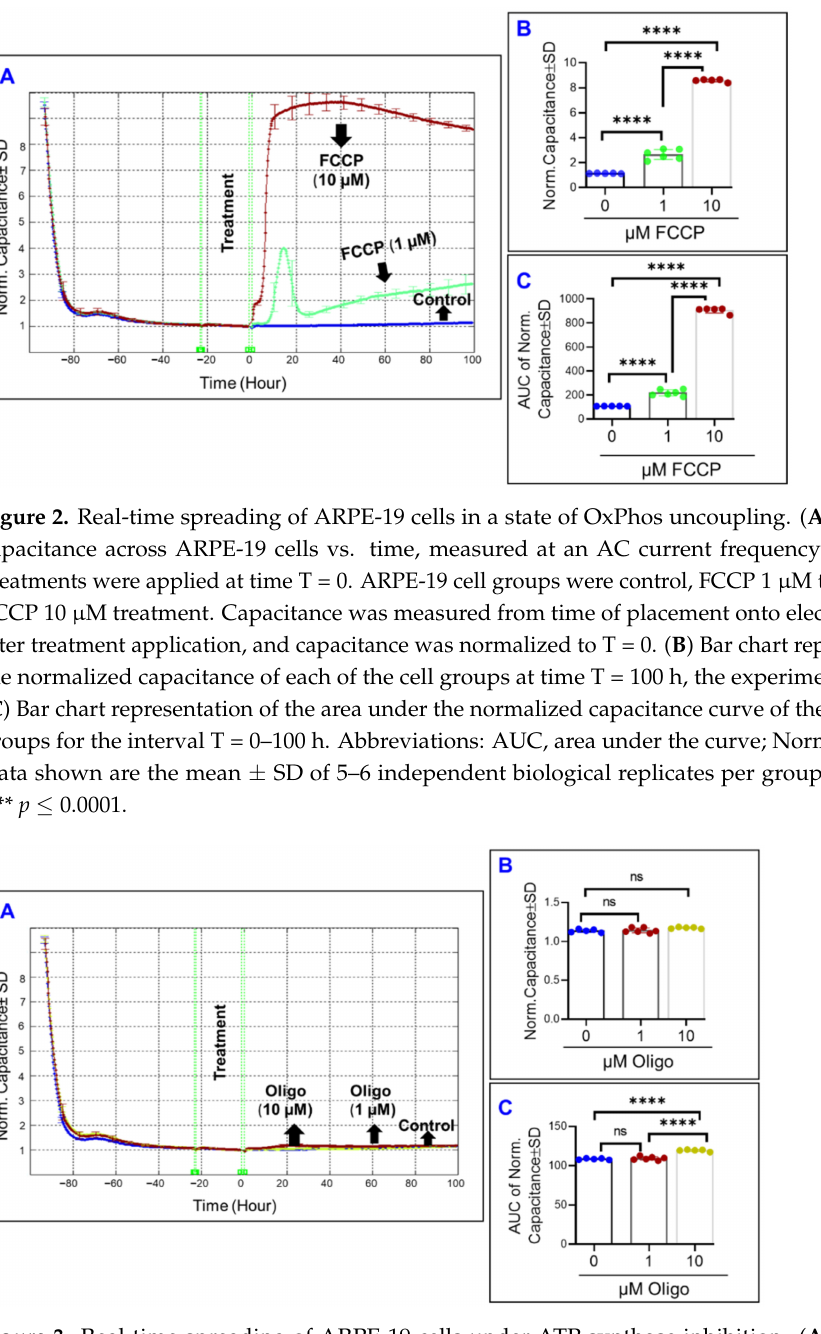
Figure 3. Real-time spreading of ARPE-19 cells under ATP synthase inhibition. ( A ) Normalized capacitance across ARPE-19 cells vs. time, measured at an AC current frequency of 64,000 Hz. Treatments were applied at time T = 0. ARPE-19 cell groups were control, 1 µ M, and 10 µ M oligomycin treatment. Capacitance was measured from time of placement onto electrode to 100 h after treatment application, and capacitance values were normalized to that at T = 0. ( B ) Bar chart representation of the normalized capacitance of each of the cell groups at time T = 100 h, the experiment’s endpoint. ( C ) Bar chart representation of the area under the normalized capacitance curve of the ARPE-19 cell groups for the interval T = 0–100 h. Compared to the control, the oligomycin 10 µ M group affects cell spreading behavior on average across treatment duration, but no effect remains by the end of the experiment. Abbreviations: AUC, area under the curve; Norm, normalized; ns, no significance. Data shown are the mean ± SD of 5–6 independent biological replicates per group. p values are **** p ≤